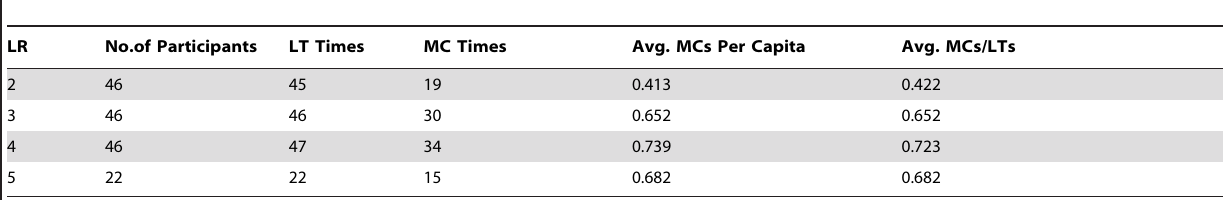
Table 1. The leveraging and margin call levels of experiments.